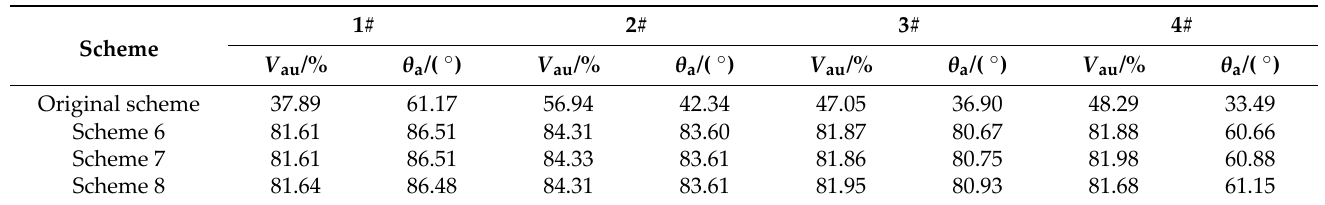
Figure 20. Diagram of axial velocity before the bell mouth in the sump 4#. Table 4. Axial velocity uniformity and axial velocity weighted average angle of Section 5 for each scheme.